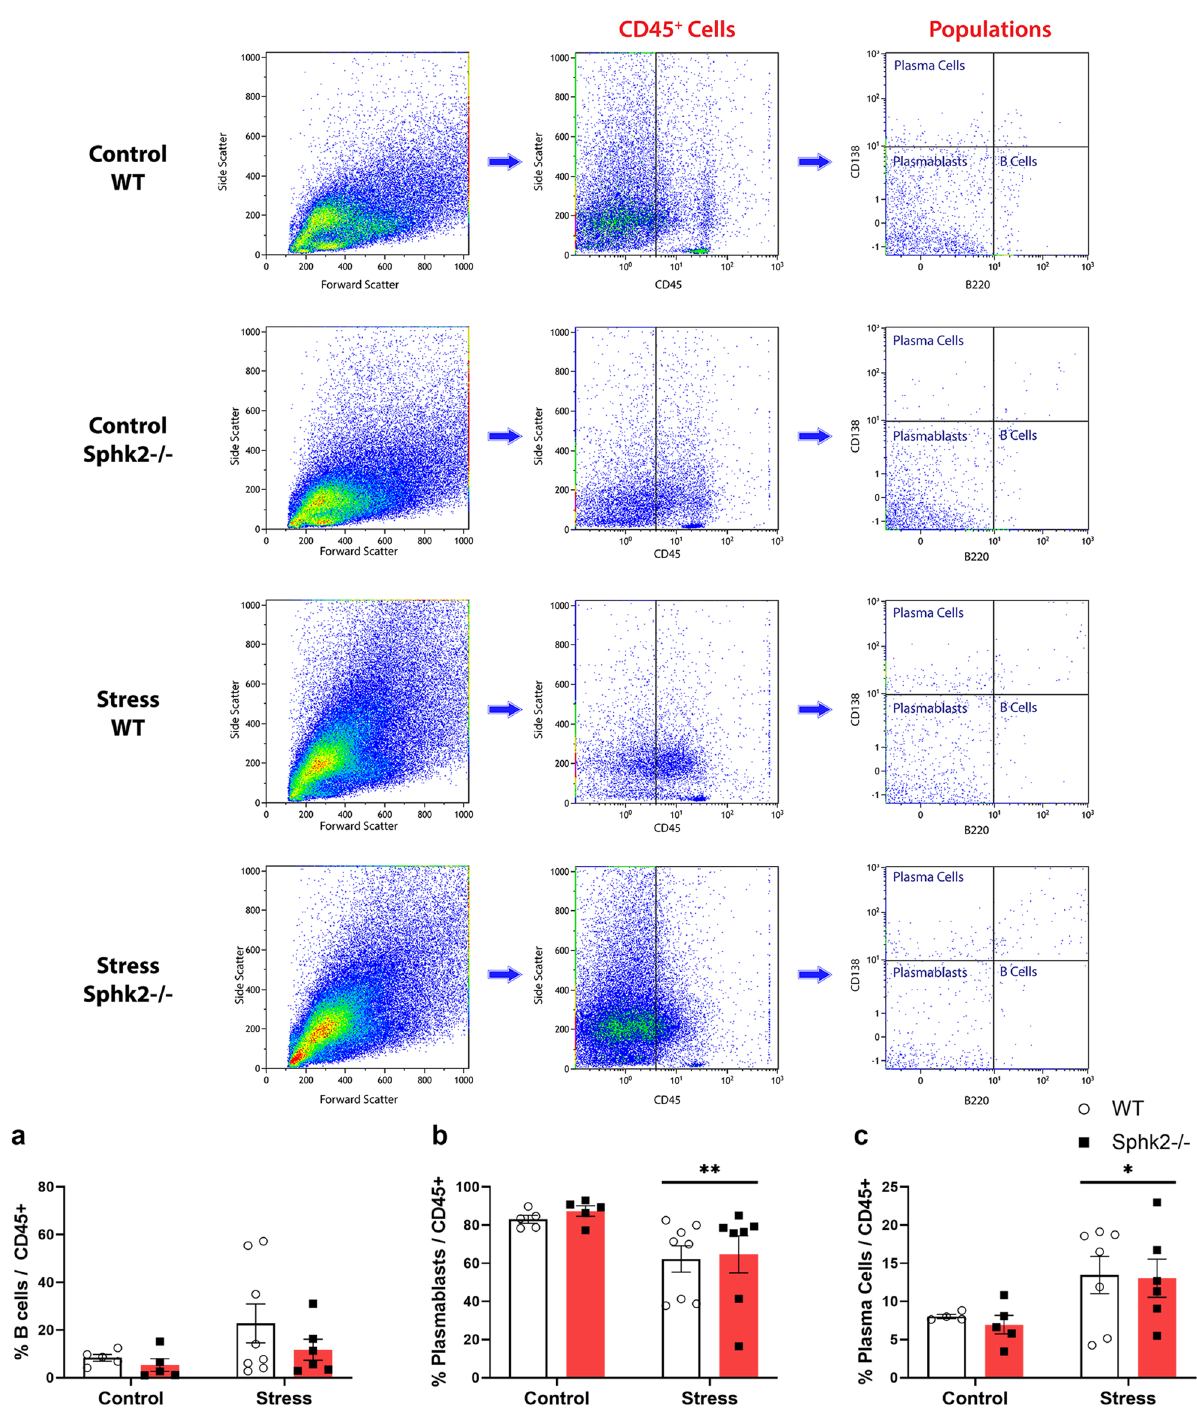
Figure 4. Flow cytometry analysis of B cell differentiation in the colon of WT and Sphk2−/− mice after sub- chronic stress exposure. Representative dot plots showing the gating strategy used to distinguish lymphoid lineage cells (CD45+), B cells (CD45+B220+CD138−/low), plasmablasts (CD45+B220−CD138−/low), and plasma cells (CD45+B220−CD138high). Considering the total number of CD45+ cells as 100%, percentage of B cells ( a ), plasmablasts ( b ), and plasma cells ( c ) were plotted. Data are means ± SEM of 5–8 mice per group. Two-way ANOVA considering stress (S) and Sphk2−/− as independent variables followed by Tukey’s post hoc; *S p < 0.05, **S p < 0.01. Sphk2: Sphingosine kinase 2; WT: wild-type; Sphk2−/−: Sphk2